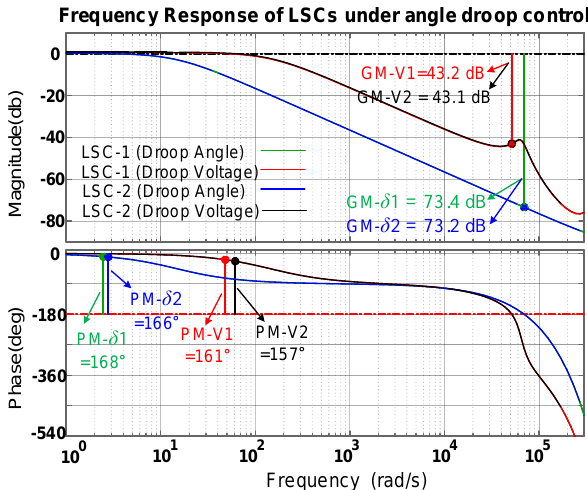
Figure 9. Frequency response plots of LSC operating under modified angle-voltage droop control.